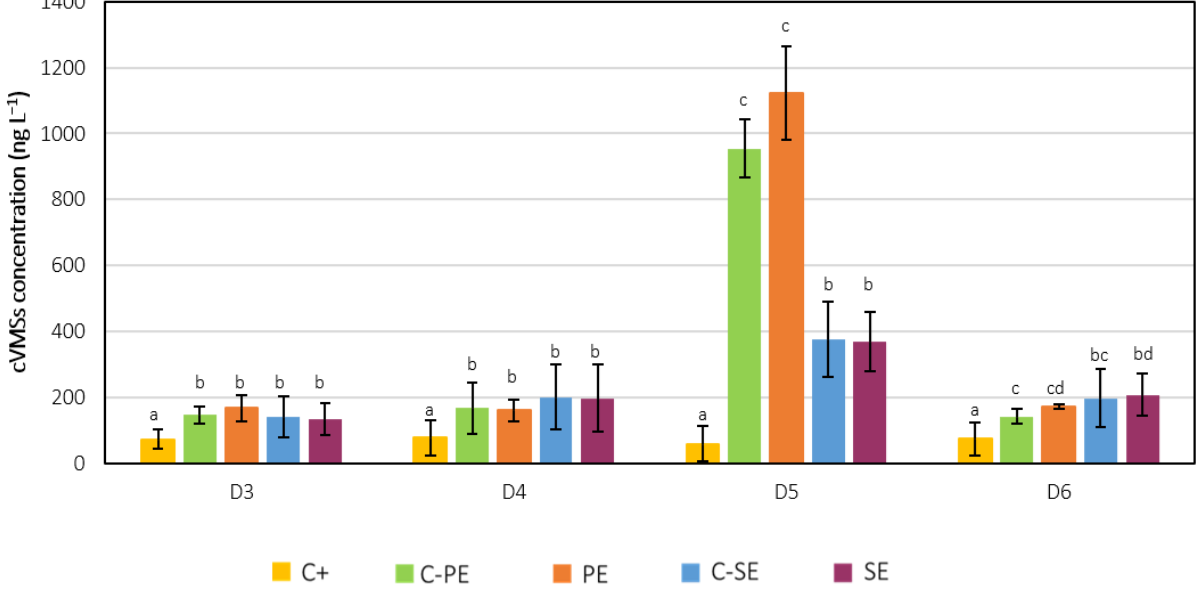
Figure 7. Initial D3, D4, D5 and D6 siloxane concentration in the cell-free culture medium in each experiment. Error bars correspond to the standard deviation of the mean obtained from two independent experiments. For each siloxane, average values sharing at least one common letter (a, b, c, and d) are not statistically different ( p > 0.05).